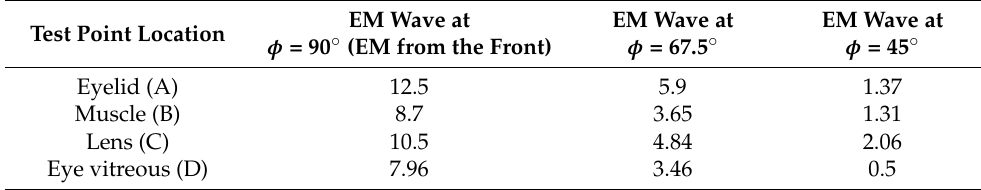
Table 1. The comparison of the Poynting vector values [W/m 2 ] at the test points, depending on the angle of the EM wave in the x–y plane.